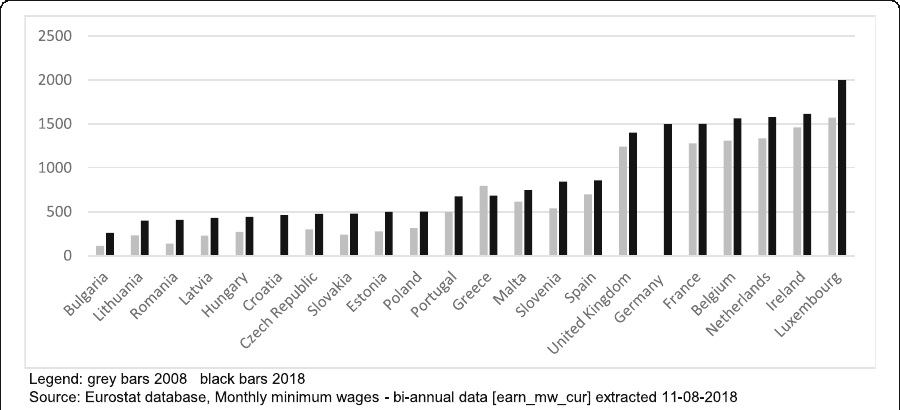
Fig. 4 Minimum wages in European Countries 2008 and 2018 [ €